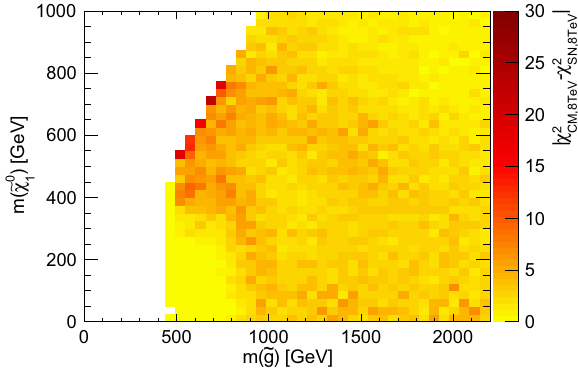
Fig. 9 Difference between the CheckMATE and SCYNet χ 2 predictions in the gluino–neutralino mass plane for all 8 TeV validation points. In each bin the mean difference has been calculated for all validation points